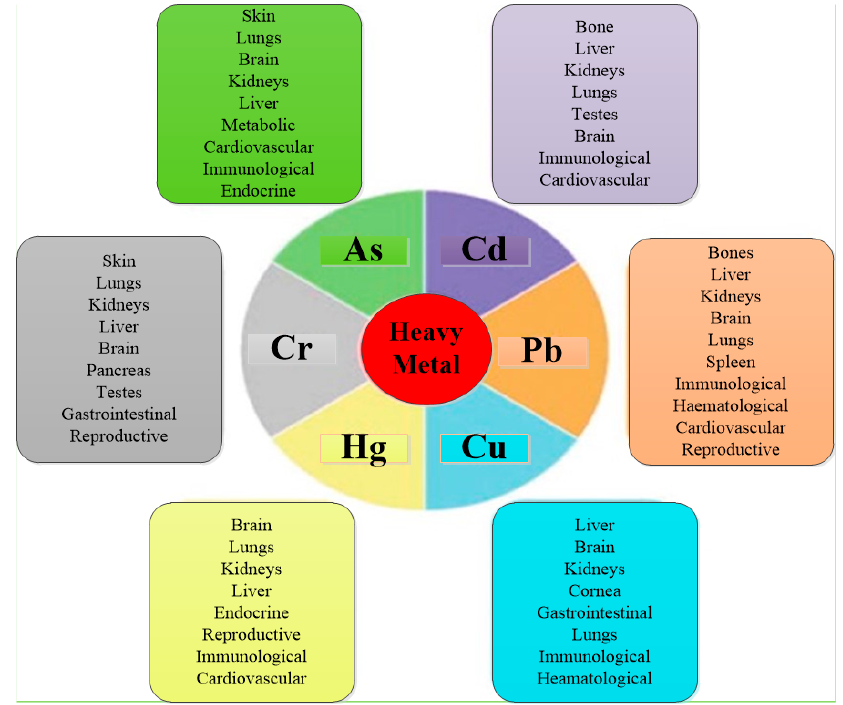
Figure 2. Harmful effects of heavy metals on human health. Figure was reproduced from [68].